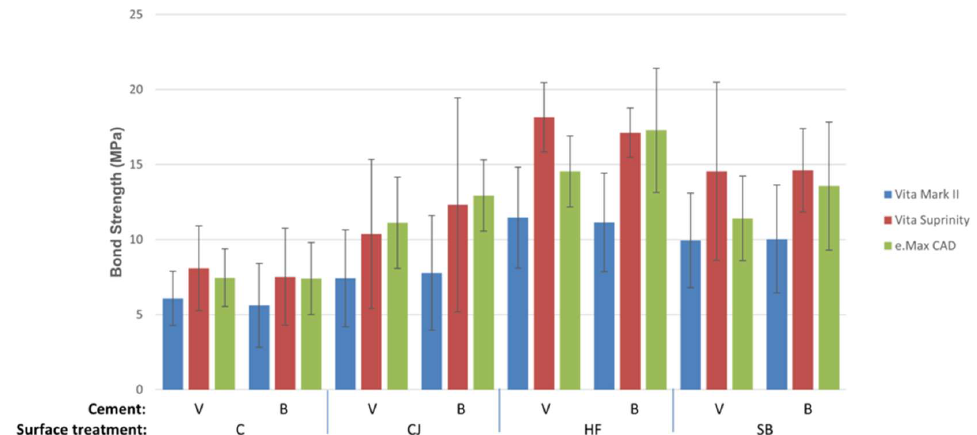
Figure 1. Mean and standard deviations of micro-shear bond strength values (MPa). C, control group; CJ, silica-coated group; HF, hydrofluoric acid etching group; SB, sandblasted group; V, Variolink; B, BisCem. Table 2. Three-way ANOVA results of micro-shear bond strength values.